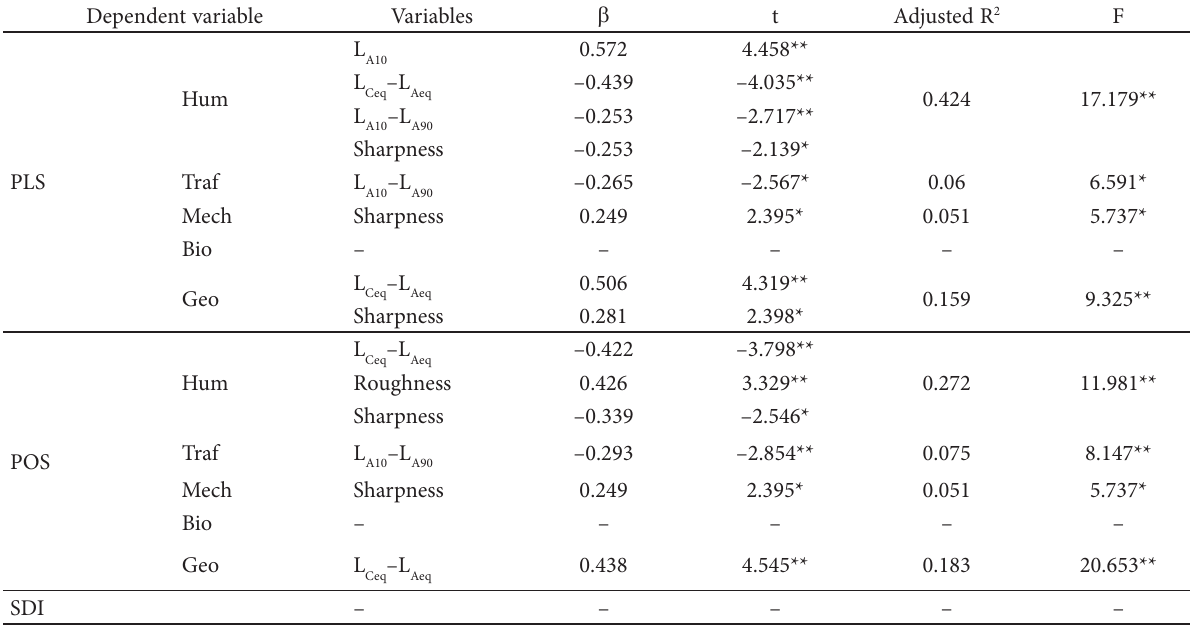
Table 3. Regression analysis results between each of the soundscape composition parameters and the physical and psychoacoustic parameters, where no relationship was shown are marked with “—”; * p < 0.05, ** p < 0.01